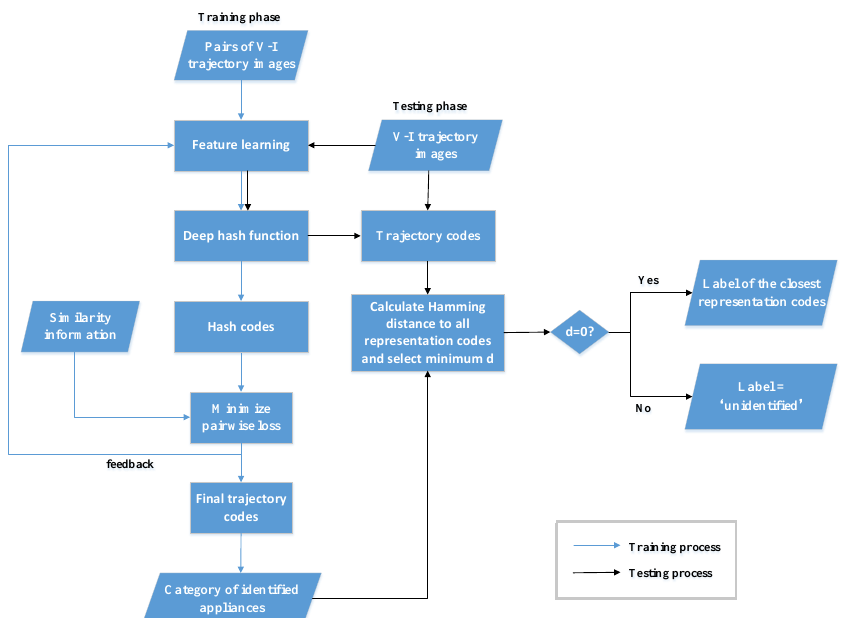
Figure 1. The work flow of the deep pairwise-supervised hashing (DPSH) method that is able to detect unidentified appliances.